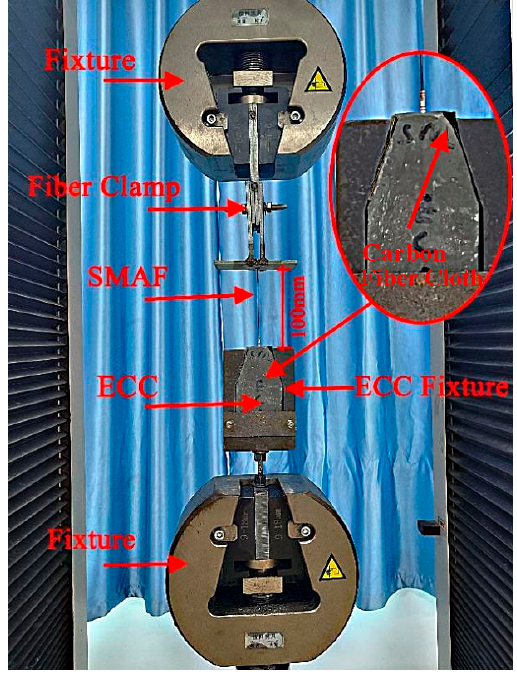
Figure 8. Test devices.